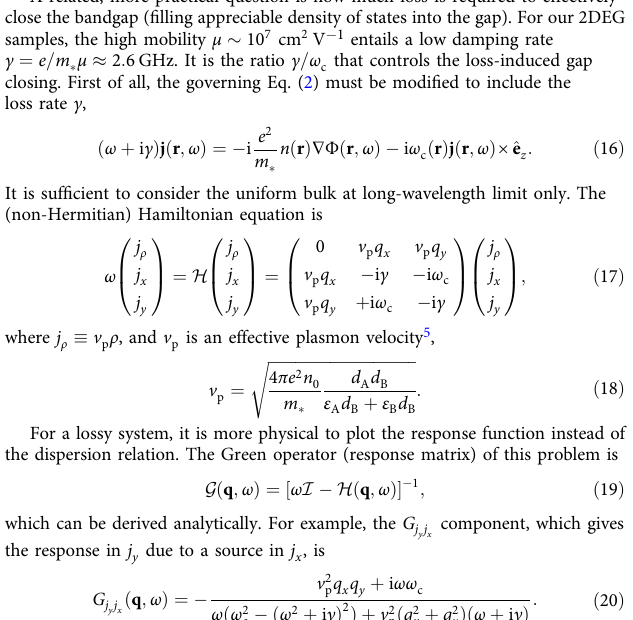
ð q ¼ q ^ e ; ω Þ for different loss x y j x